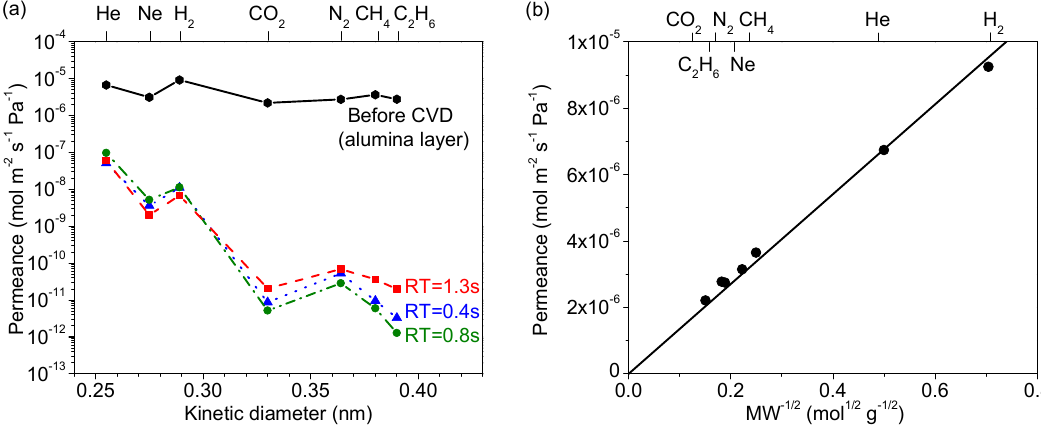
Figure 4. ( a ) Gas permeances at 300 °C of the MTMOS-derived membranes deposited at 650 °C with residence times of 0.4 s, 0.8 s, and 1.3 s. ( b ) Gas permeances at 300 °C through the alumina layer before CVD showing Knudsen selectivity.